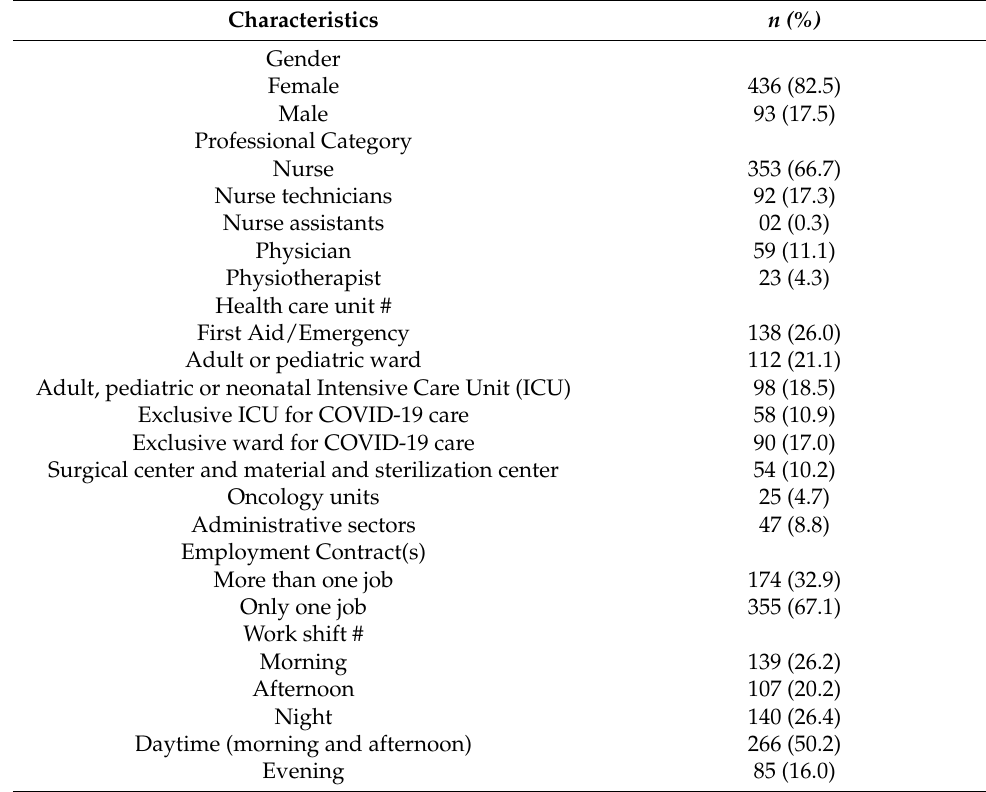
Table 1. Individual and occupational status of participants ( n =